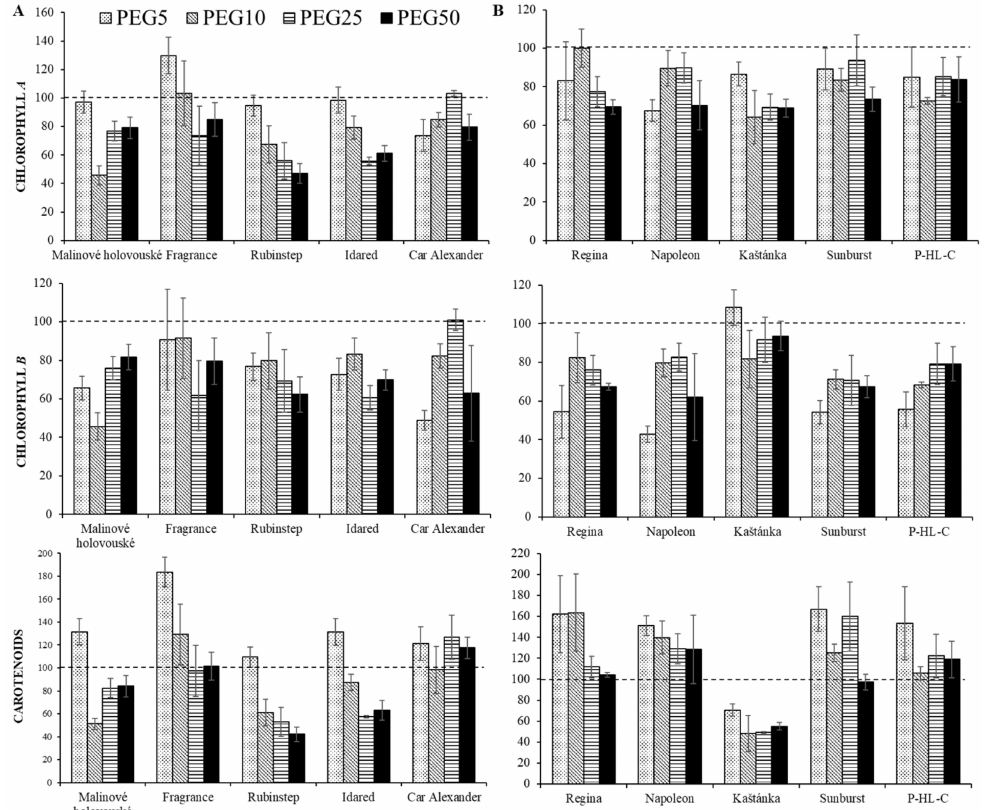
Figure 3. E ff ect of di ff erent concentration of PEG-6000 on content of chlorophyll a (mg g − 1 FW), chlorophyll b (mg g − 1 FW) and total carotenoids (mg g − 1 FW) in in vitro culture of apple ( A ) and cherry ( B ) cultivars. All bar values were recalculated relative to the compound content in untreated samples taken as 100% (dashed line). Error bars represent means ± SDs (n =